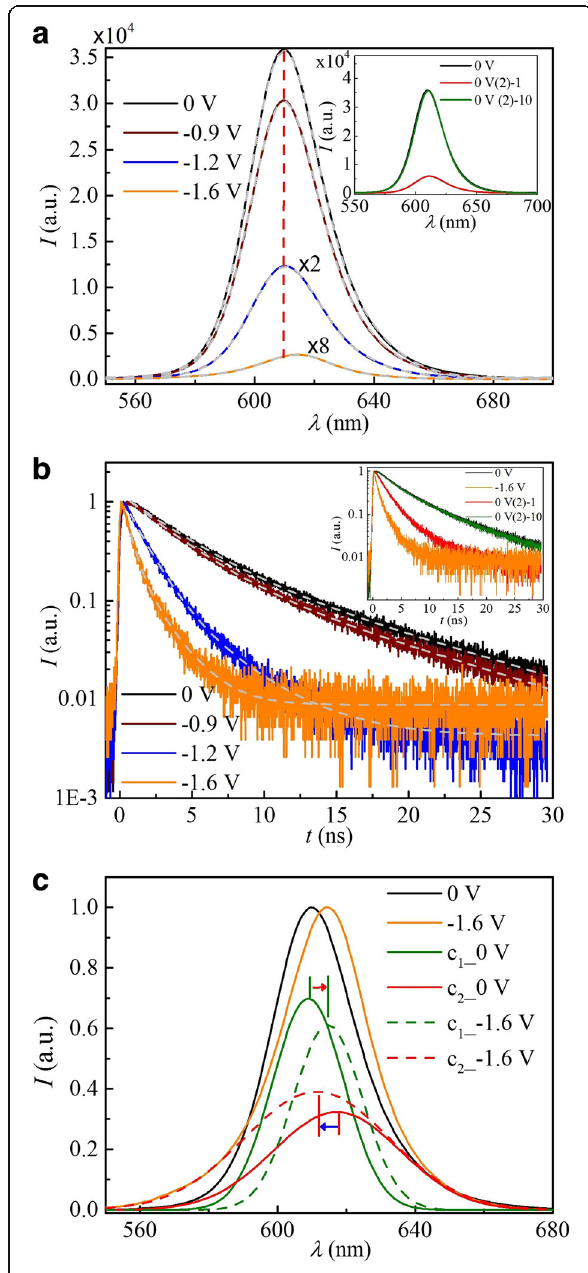
Fig. 3 Representative spectra at typical applied potentials. a Steady-state spectra and b PL decay dynamics. The QDs show a higher PL quantum yield and slower decay rate (black solid) at 0 V. After the applied potential reaches − 0.9 V (wine solid), the PL is quenched with continuous redshift. When the potential is set to − 1.6 V (orange solid), the PL shows considerable quenching. When the potential is reset to 0 V, the spectral intensity and shift exhibit partial recovery instantaneously (inset, 0 V (2)-1, Red solid) and recover completely in ~ 1800 s (inset, 0 V (2)-10, green solid). c Normalized PL spectra at 0 V (black solid) and − 1.6 V (orange solid). Each of the two PL spectra can be fit to a sum of two Gaussian functions; the individual Gaussian functions are labeled by c 1 and c 2 , the solid curves represent the two functions at 0 V, and the dashes represent the two functions at − 1.6